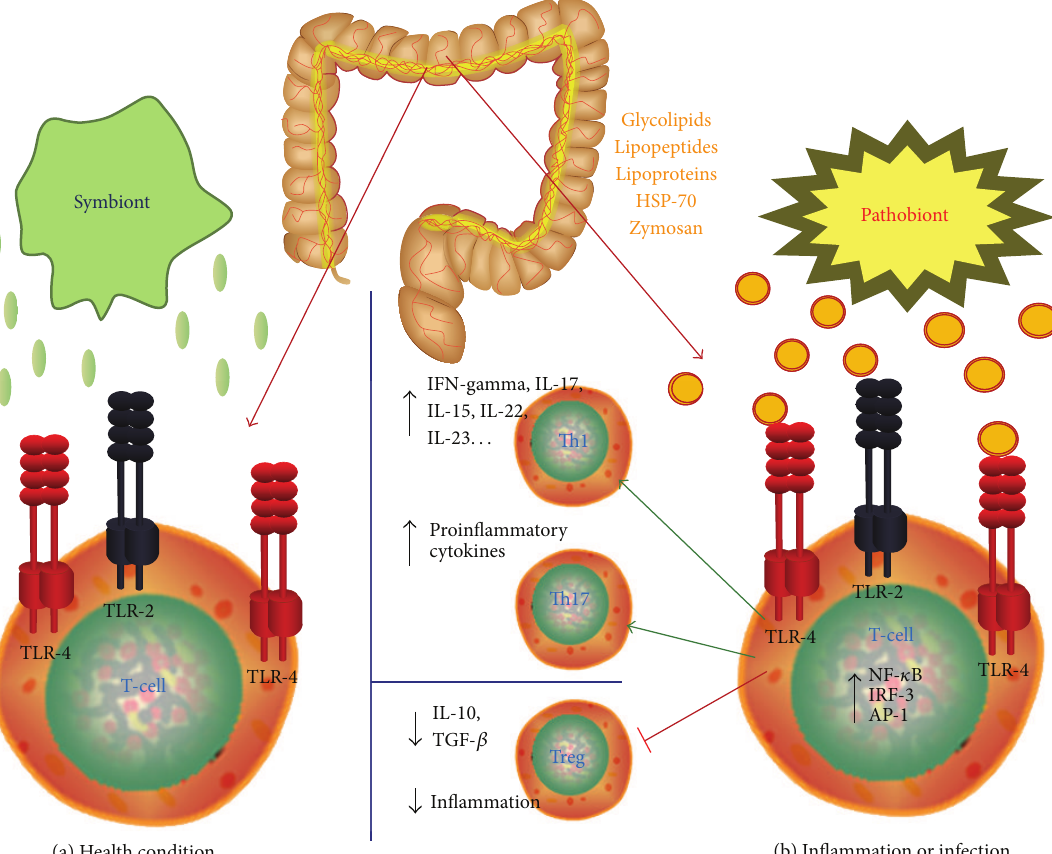
Figure 1: TLRs in human gastrointestinal pathology: health condition and inflammation. (a) In healthy human intestine, a constant homeostasis is maintained by the perfect regulation of microbial load and the immune response generated against it. (b) Failure of this balance may result in various pathological conditions. TLRs may be considered an interface among intestinal epithelial barrier, microbiota, and immune system. TLRs pathway, activated by pathogens, is involved in the pathogenesis of several infectious and inflammatory diseases. TLR signaling critically contributes to acute and chronic intestinal inflammatory